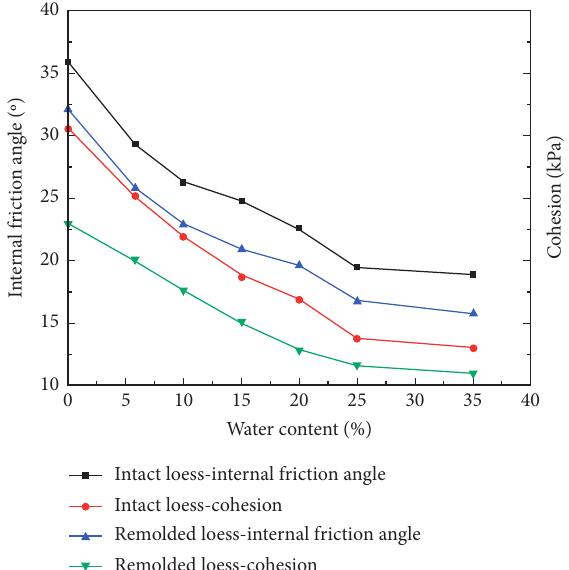
Figure 5: Relationship between internal friction angle, cohesion, and water content of intact loess and remolded loess.